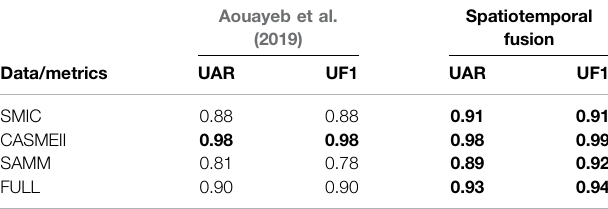
TABLE 7 | Performance on three classes based MEGC with LOSO-CV.